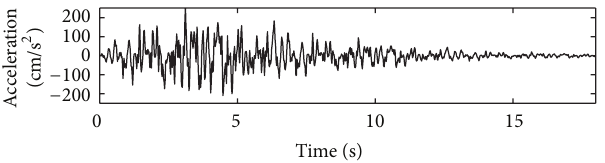
Figure 1: Record of the El-Centro seismic ground